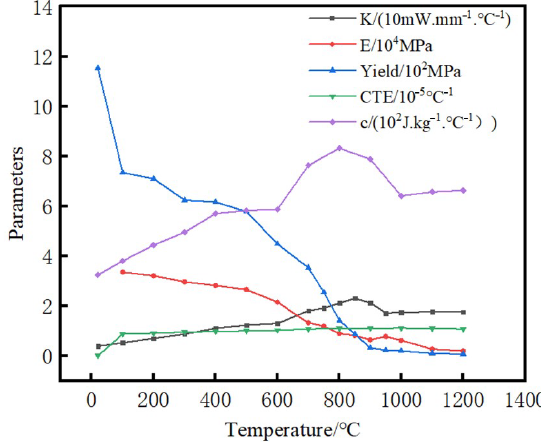
Figure 1. TC17 titanium alloy material parameters.